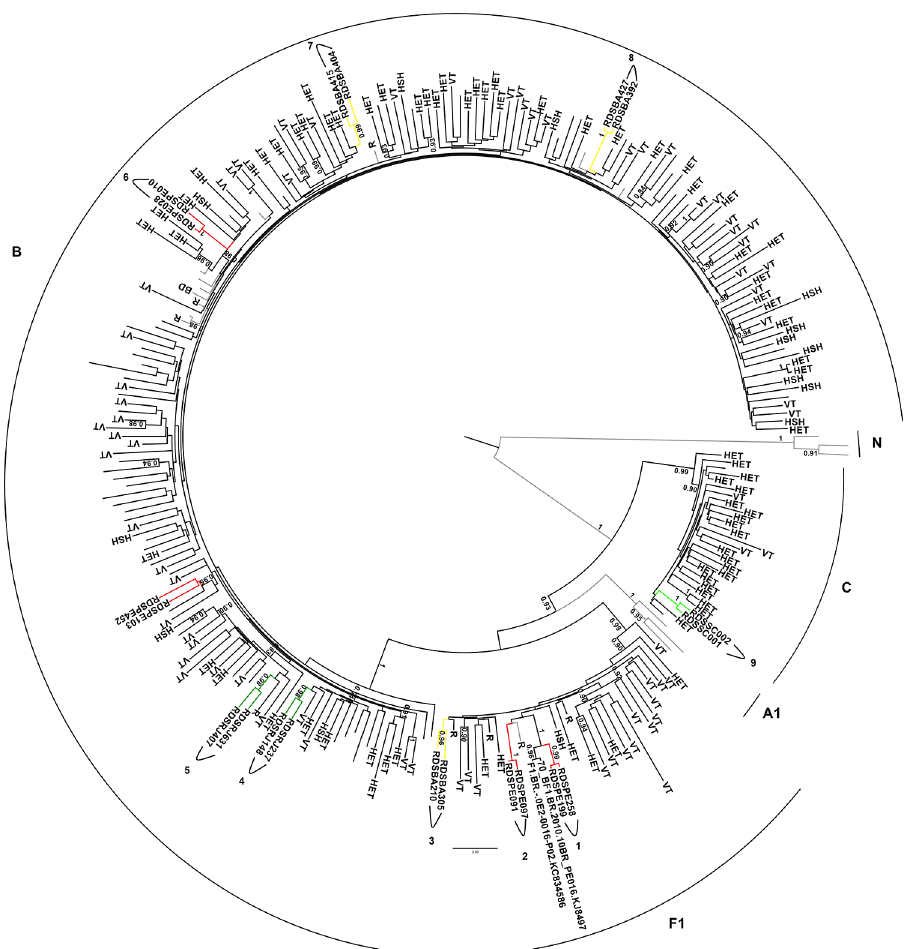
Fig 2. Pol ML tree (2265 – 3519 relative to HXB2) from Brazilian RDS drug users clusters and reference sequences with highest similarity score to each group selected by HIV BLAST, as well as, Brazilian sequences with assigned transmission category [heterosexual (HET), homosexual (HSH), blood donor (BD) or vertical transmission (VT)] belonging to subtypes B, C and F1. The aLRT support values superior to 0.90 are indicated. Horizontal branch lengths are drawn to scale with the bar at the bottom indicating nucleotide substitutions per site.